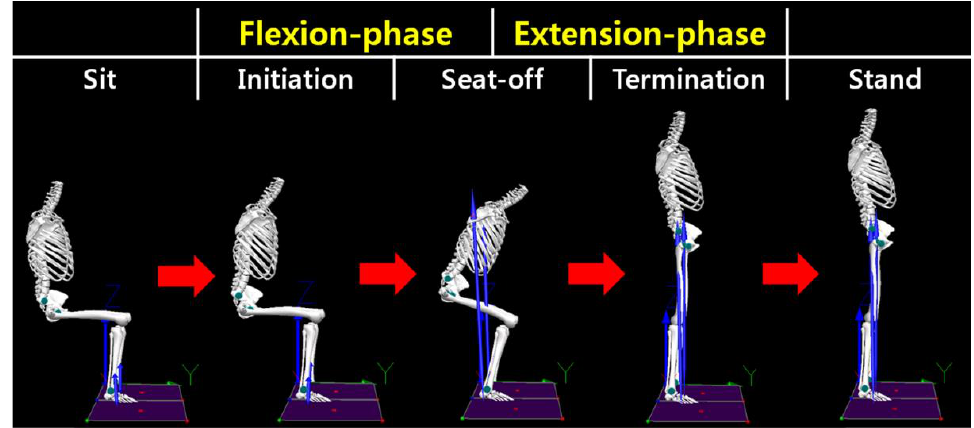
Figure 4. Indicators and classification of the sit-to-stand motion.